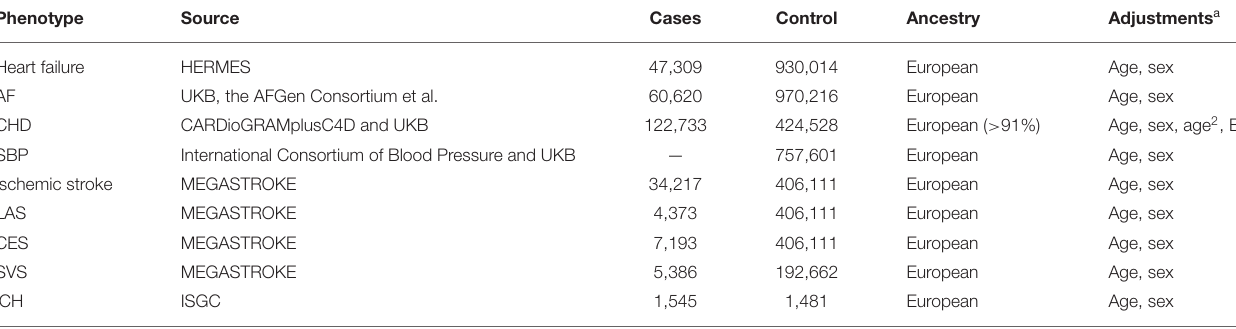
TABLE 1 | Descriptive characteristics of the GWAS meta-analyses used in the current Mendelian randomization study. Phenotype